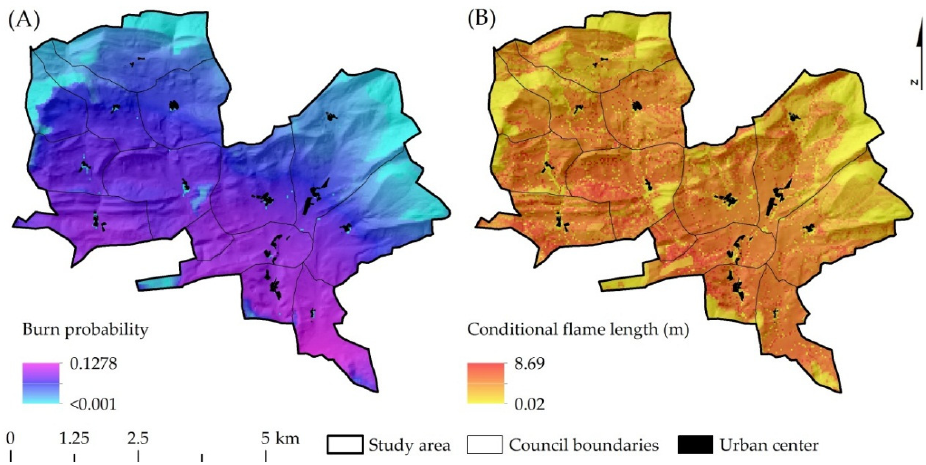
Figure 8. Conditional burn probability ( A ) and conditional flame length ( B ) output maps for the study area. Fires were modeled at 20-m resolution under 97th percentile fire weather conditions. The urban centers containing the bulk of residential structures are indicated with black polygons.